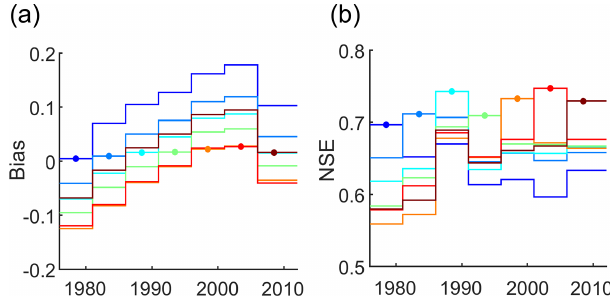
Figure 3. (a) Bias and (b) NSE for the different subperiods aver- aged over all study catchments for the baseline model V 0. Each line refers to models calibrated in one subperiod, showing bias and NSE during calibration (marked by the filled circles) and during evaluation in the other six